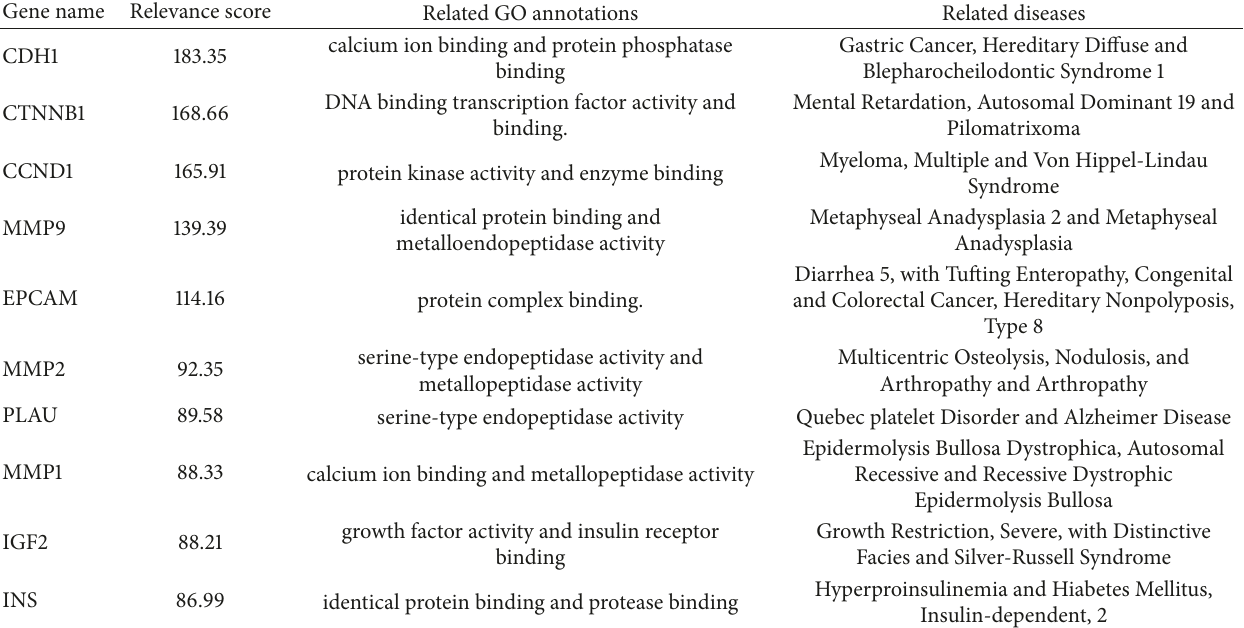
Table 3: The top ten genes among the COAD HNSC PAAD data by